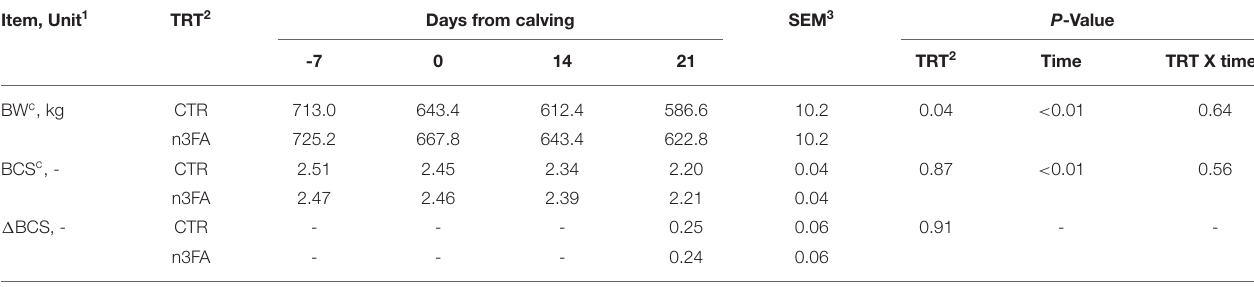
TABLE 3 | Trends of body weight and body condition score in dairy cows infused with 150ml of sterile saline or 150ml of a 10% solution containing purified fish oil rich in long-chained Omega-3 fatty acids at 12, 24, and 48h after calving. Item, Unit 1 TRT 2